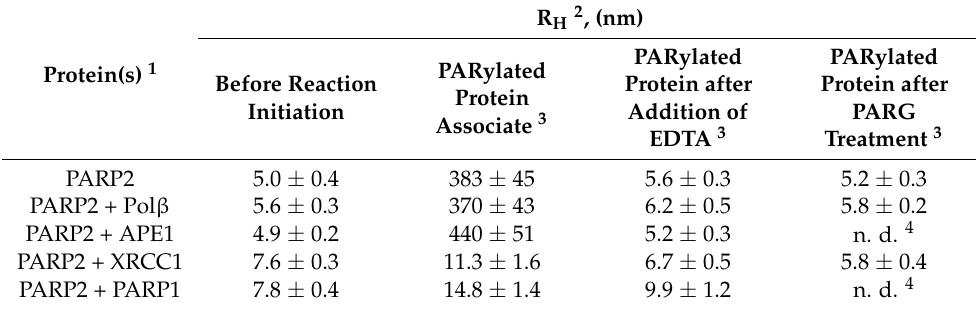
Table 4. DLS analysis of PARylated